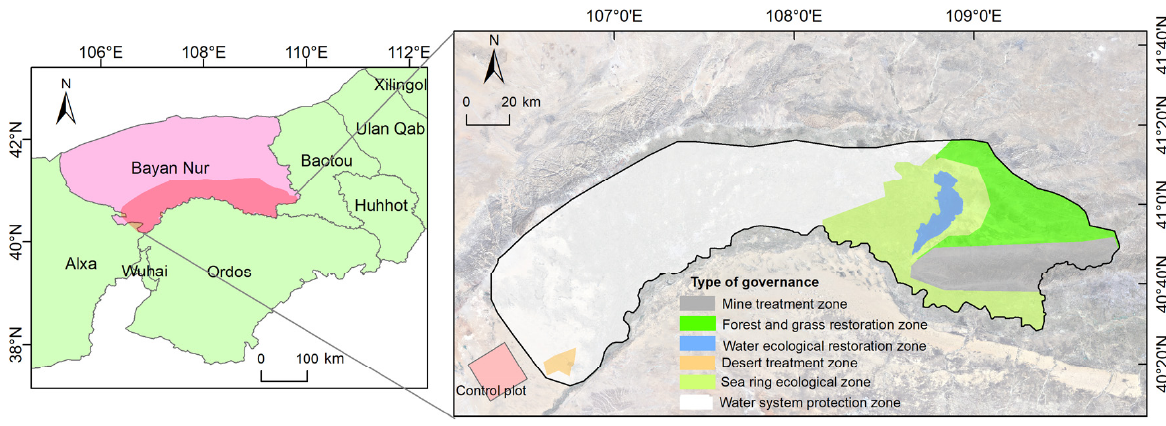
Figure 1. Distribution of main treatment areas in the Wuliangsuhai Basin.